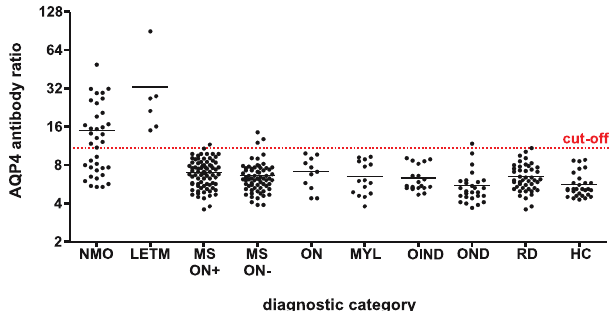
Figure 2. Antibody Ratios Found in Patients with NMO and in Patients with Relevant Differential Diagnoses or Healthy Controls Each individual value represents the result from a single serum sample tested twice with the AQP4 RIPA. Black horizontal bars represent mean. The dashed horizontal line indicates the cutoff at an antibody ratio of 11. Diagnostic categories: NMO, neuromyelitis optica; LETM longitudinally extensive transverse myelitis; MS/ON þ , multiple sclerosis with optic neuritis; MS/ON (cid:2) , multiple sclerosis without optic neuritis; ON, optic neuritis; MYL, myelitis extending over fewer than three vertebral segments on MRI; OIND, other inflammatory neurological disorders and systemic disorders with neurological involvement (e.g., neuro- borreliosis, chronic inflammatory demyelinating polyneuropathy; for exact classification see legend for Table 1); OND, other noninflammatory neurological diseases (e.g., carpal tunnel syndrome); RD, rheumatological diseases without neurological involvement (for exact classification see legend for Table 1); HC, healthy controls.